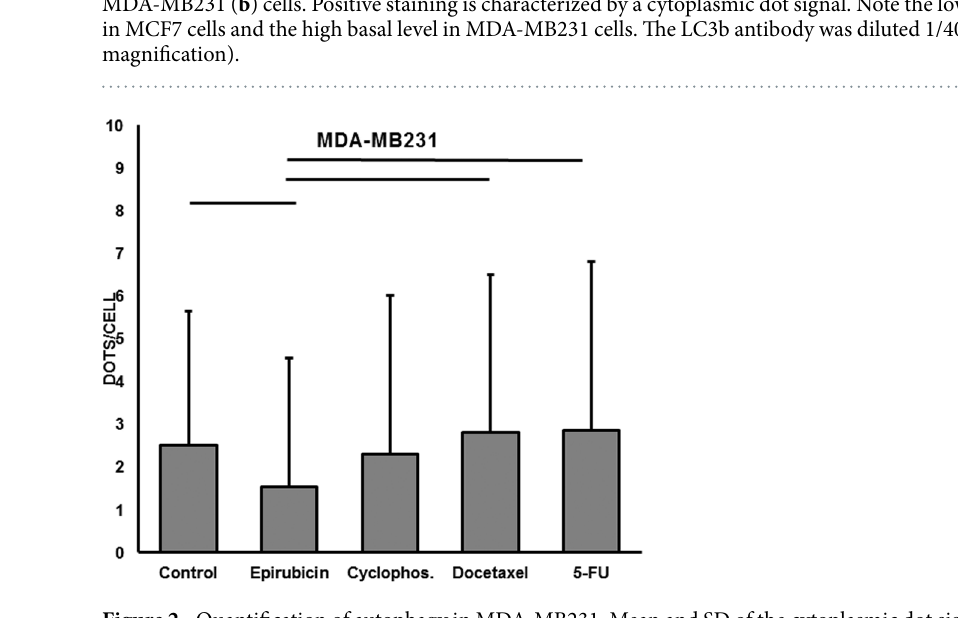
Figure 2. Quantification of autophagy in MDA-MB231. Mean and SD of the cytoplasmic dot signals of LC3b in 100 cells from each MDA-MB231 culture. Line illustrates a p-value < 0.05 (Mann-Whitney test). Significant differences were observed between the control and epirubicin-, docetaxel- or 5-FU-treated